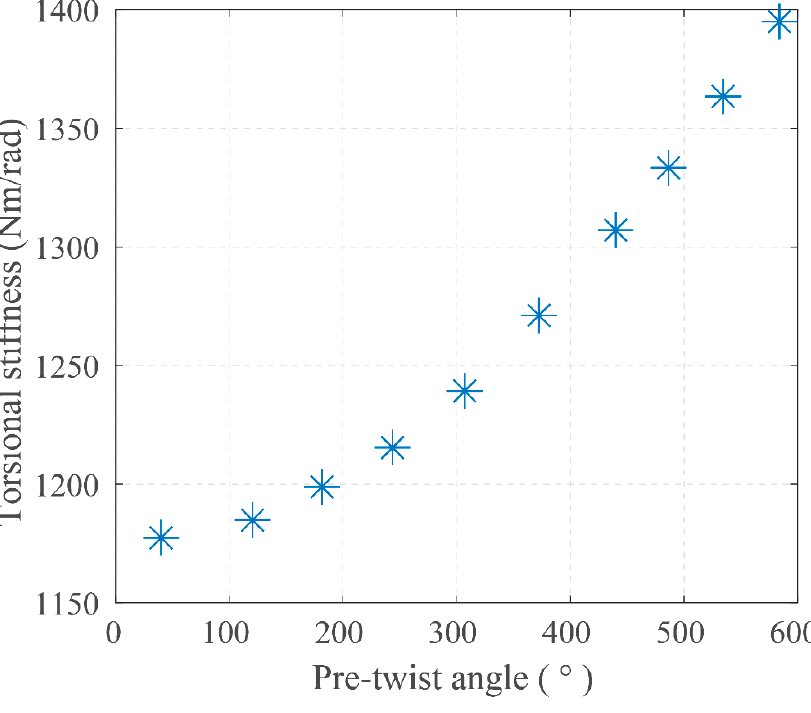
Figure 6. Torsional stiffness versus total pre-twist angle for the solid drill, according to the 3D FEM model.